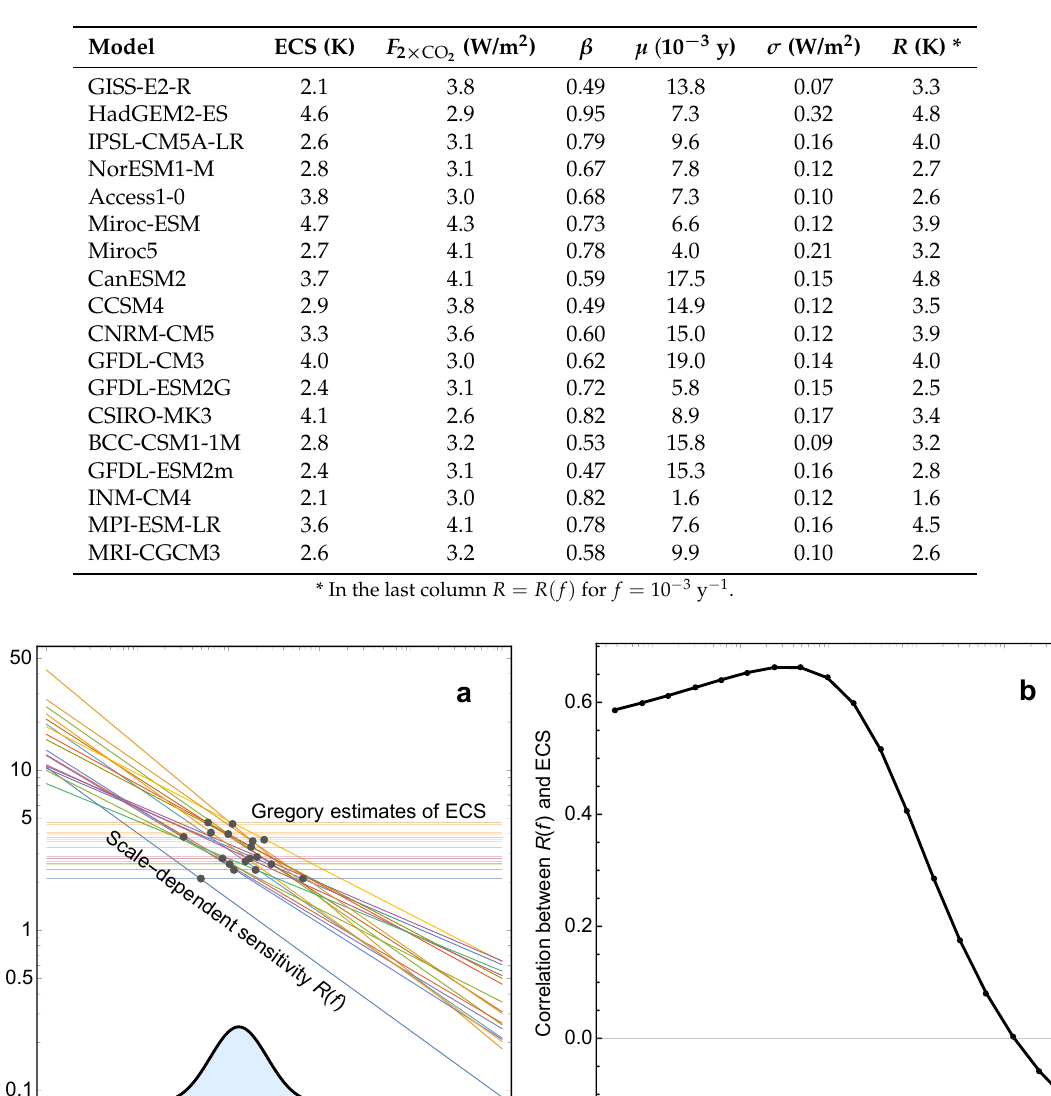
Table 1. Estimated quantities for the Earth system model (ESM) in the ensemble. The columns for equilibrium climate sensitivity (ECS) and F 2 × CO are obtained from Gregory plots for 4 × CO 2 runs 2 and taken from [1]. The columns denoted β , µ and σ show the estimates of the parameters in the model given by Equation (2) with response function given by Equation (5), obtained from historical runs of the ESMs and the modified Hansen forcing for each model. The last column displays the scale-dependent sensitivity R ( f ) obtained from Equation (6) using the values of F 2 × CO , β and µ that are listed in the 2 columns to the left, and evaluated at f = 10 − 3 y − 1 .